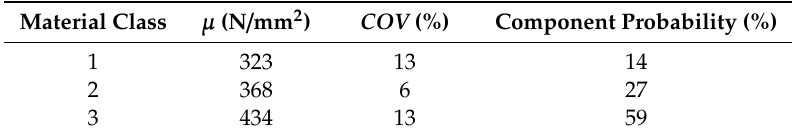
Table 2. Steel yielding strength f y —statistical parameters µ and COV of the GMM and probability of each identified